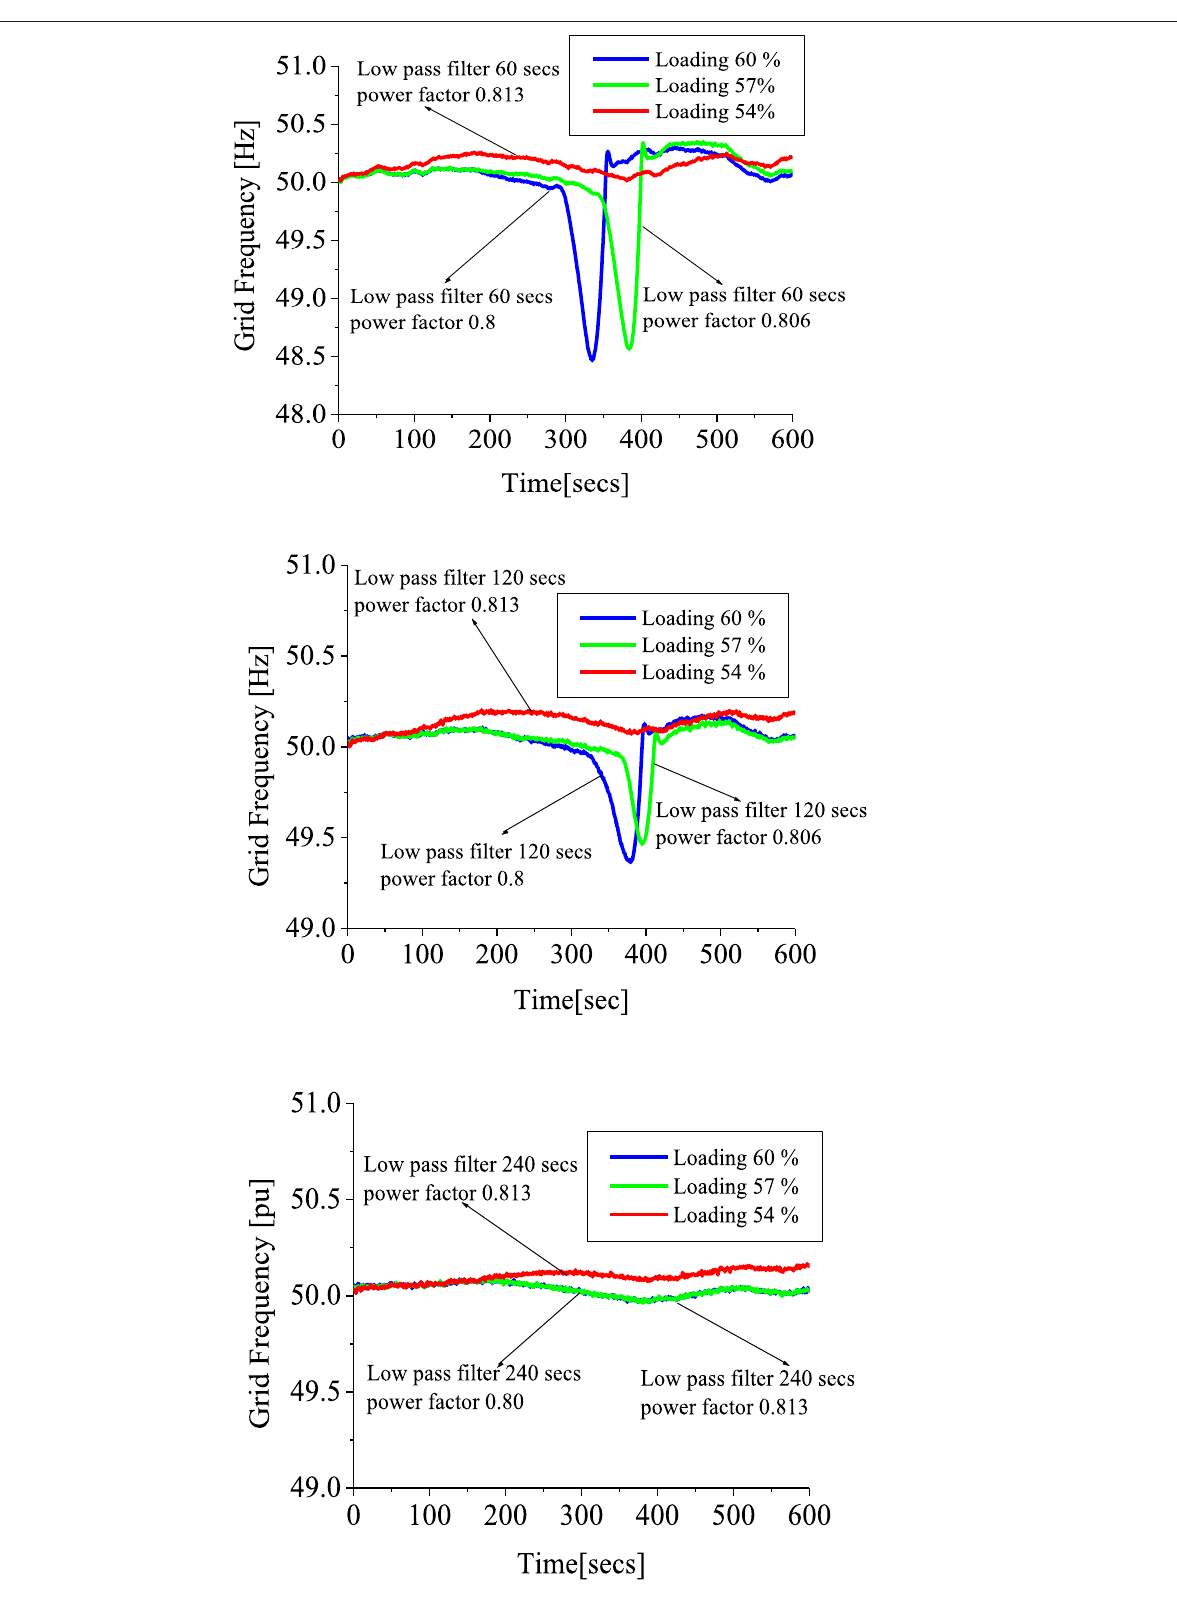
FIGURE6| Dynamicsofthesystemwithvaryingloads. (A) Dynamicsforlowpass fi lter60 s. (B) Dynamicsforlowpass fi lter120 s. (C) Dynamicsforlowpass fi lter 240 s.